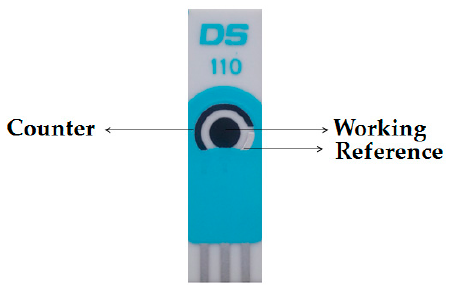
Figure 1. Unmodified screen-printed electrode ( SPE) with a three electrode configuration.